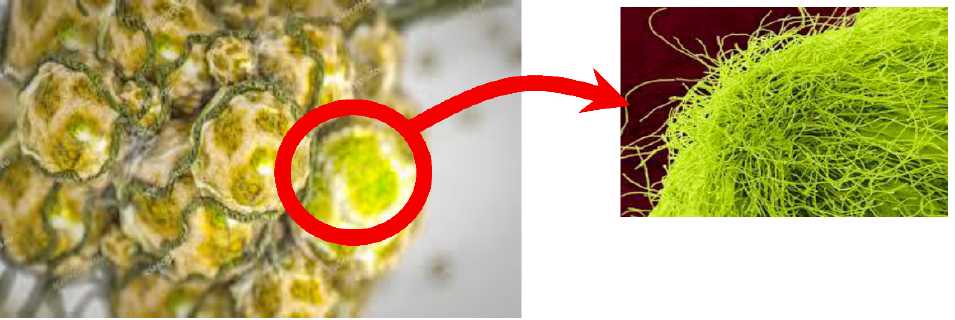
Figure 1. Filamentous fungi.